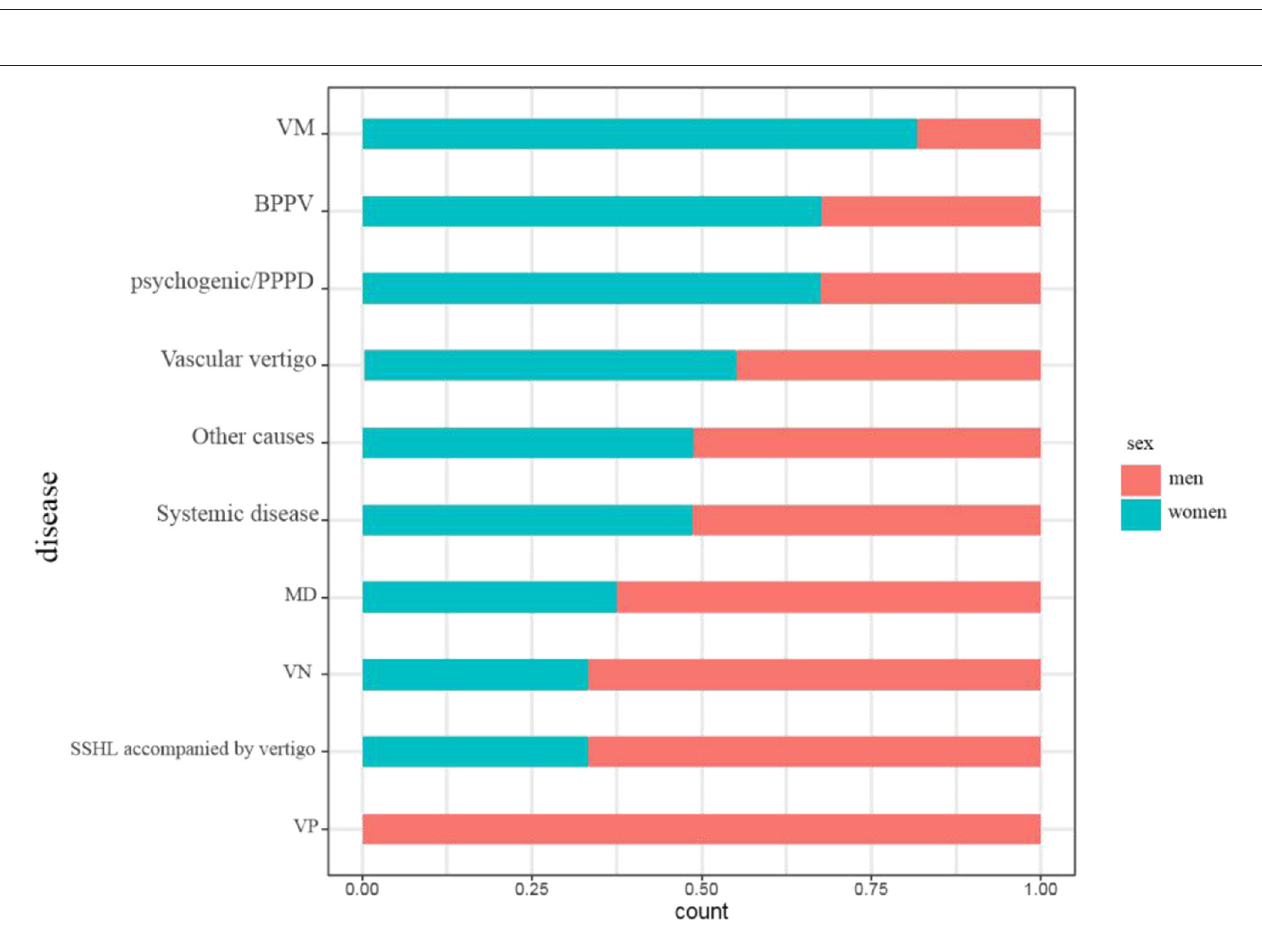
FIGURE 2 | The sex ratios of each cause during the coronavirus disease 2019 (COVID-19) epidemic.